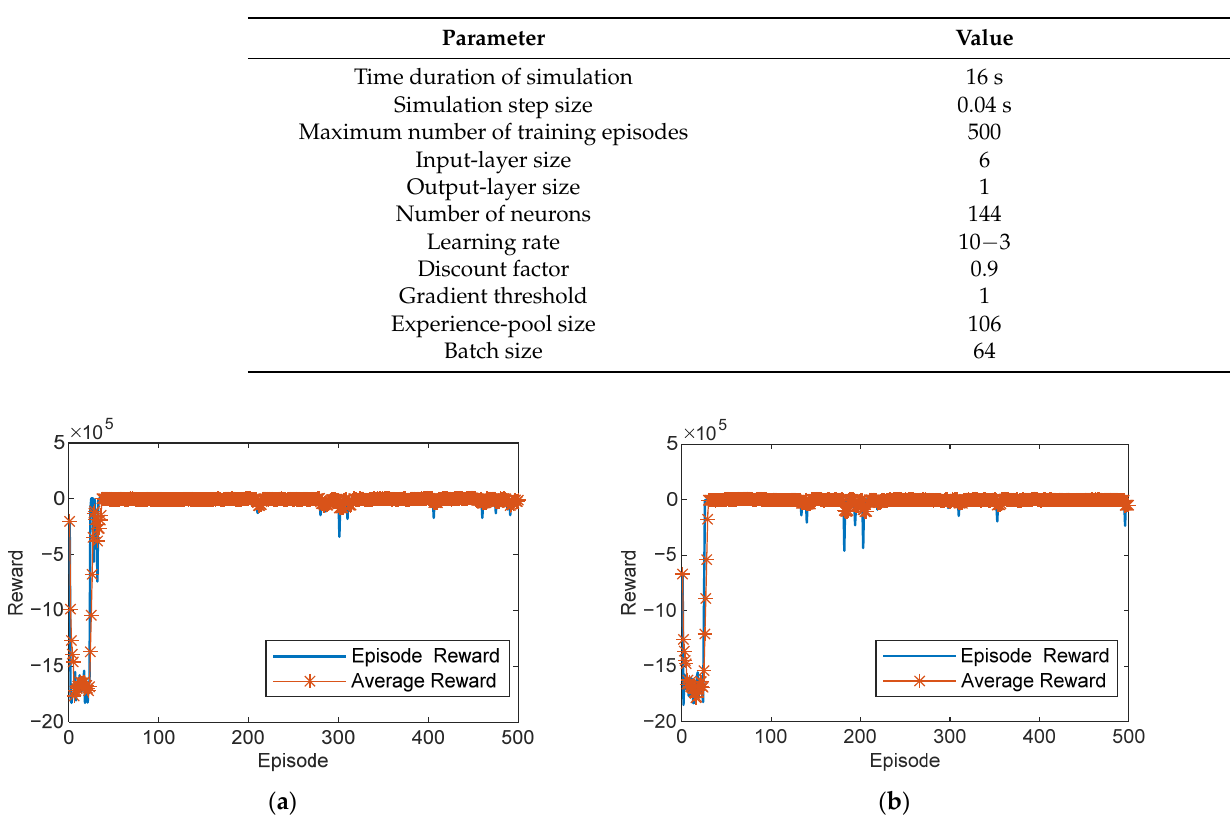
Table 3. Related parameters in RL.